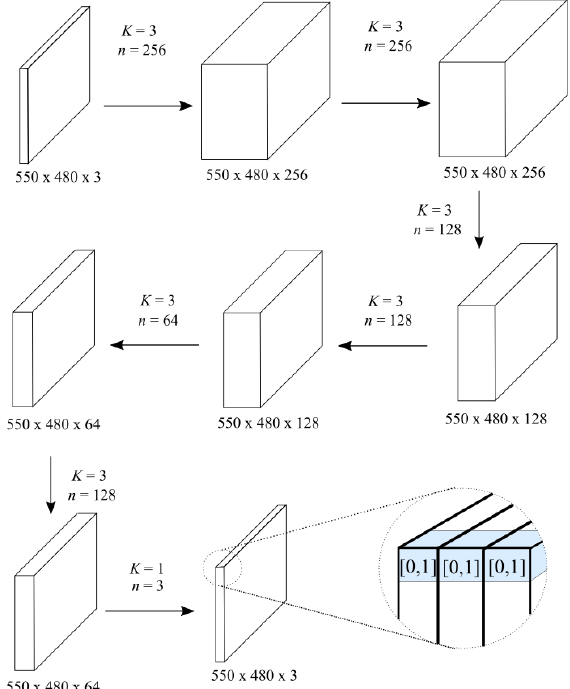
Figure 7. Convolutional Neural Network (CNN) architecture. In all cases stride = 1 and a zero-padding = 1. The output image has three channels (for sky, cloud, and ground), and each pixel is labeled based on its three channels